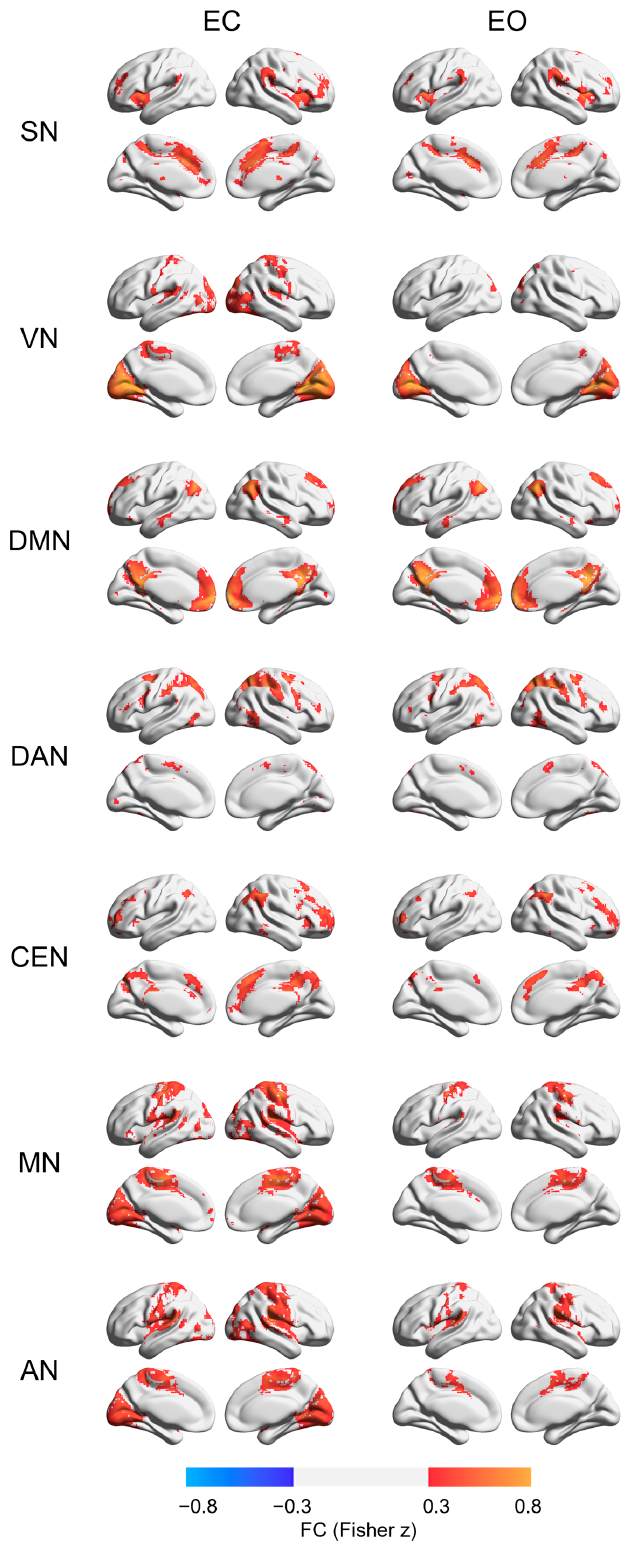
Figure A1. Seven FC maps of networks in EC and EO conditions based on Berlin dataset. The left and right column displays the FC maps of each network in EC and EO conditions, respectively. The color range of FC maps represents the Fisher z value from − 0.8 to − 0.3 and from 0.3 to